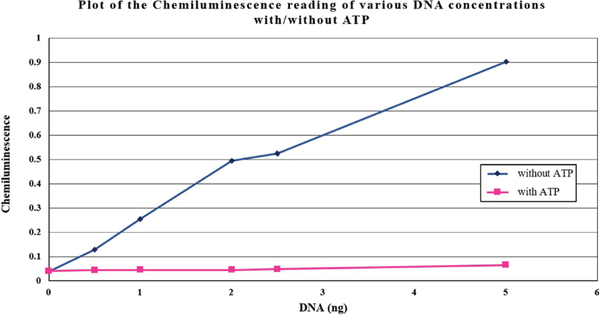
Graphical representation of Table 2 data.